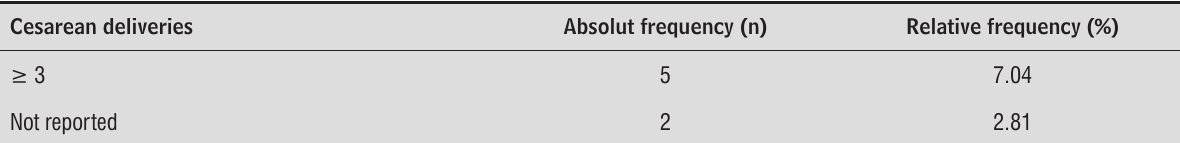
Table 1 - Socio-demographic and obstetric characteristics of women with UI